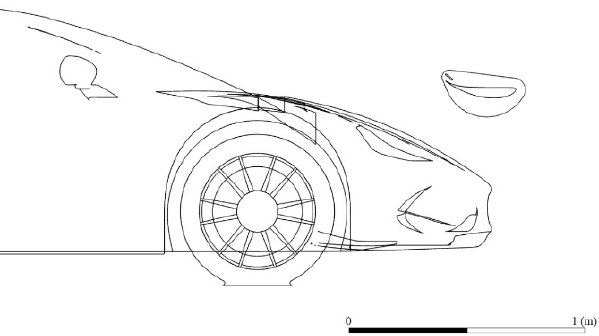
Figure 12. Front wing positioned at X = 1 m and Y = 0.5 m from the front axle of the car.